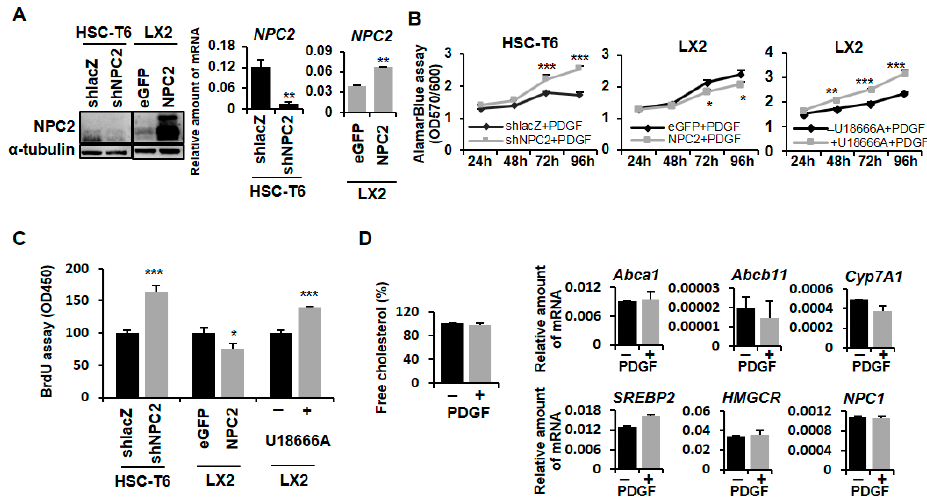
Figure 1. NPC2 downregulation induced free cholesterol accumulation which influenced PDGF-BB-induced cell proliferation in HSCs. ( A ) Western blot and real-time PCR were used to assess NPC2 gene expression in HSC-T6 shNPC2 and LX2 NPC2 stable cells; ( B ) Different lentiviruses infected HSC-T6 (shlacZ and shNPC2), LX2 (eGFP and NPC2) stable cells, and 1 µM U18666A pretreated LX2 cells were treated with 10 ng/mL PDGF-BB for the indicated time periods, and the cell viability was analyzed by adding 10 µL alamarBlue ® reagent for 2.5 h and evaluating the absorbance at 570/600 nm; ( C ) Different lentiviruses infected HSC-T6 (shlacZ and shNPC2), LX2 (eGFP and NPC2) stable cells, and 1 µM U18666A pretreated LX2 cells were treated with 10 ng/mL PDGF-BB for 72 h, and the cell viability was analyzed by using the BrdU cell proliferation assay and evaluating the absorbance at 450 nm; ( D ) LX2 cells were treated with or without 10 ng/mL PDGF-BB overnight and then subjected to intracellular free cholesterol quantification. Real-time PCR was used to assess Abca1 , Abcb11 , Cyp7A1 , sterol regulatory element-binding proteins (SREBP2 ), 3-hydroxy-3-methyl-glutaryl-coenzyme A reductase ( HMGCR ), and NPC1 in HSC-T6 cells. Data are shown as mean ± SD. * p < 0.05; ** p < 0.01; *** p < 0.001 vs. black line/bar. Each experiment was performed using three independent replicates with similar results.